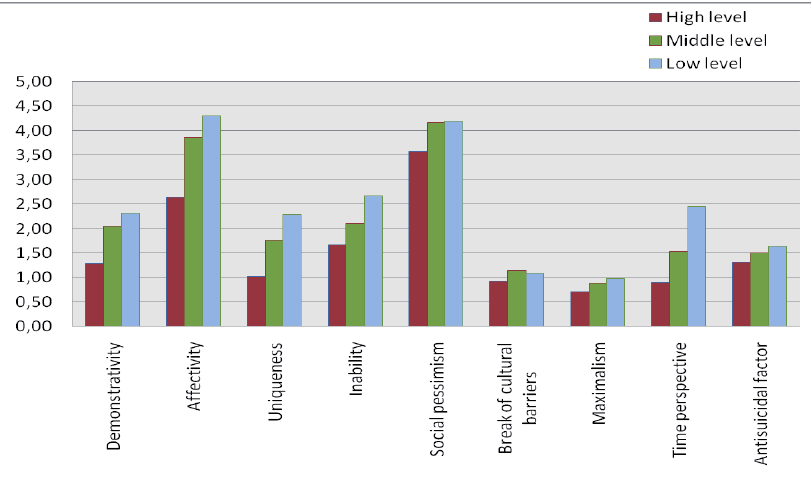
Fig. 5. Indicators of suicidal risk in groups with different level of